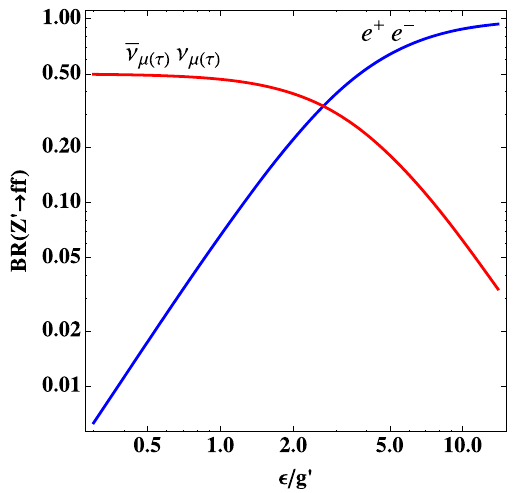
Fig. 1 BR ( Z (cid:2) → f f ) as a function of (cid:8)/ g (cid:2) where red and blue lines correspond to ¯ ν μ,τ ν μ,τ and e + e − mode respectively. The mass of Z (cid:2) is fixed to 100 MeV